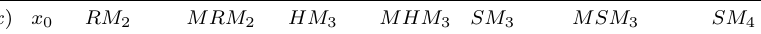
Table 4. Test Problem (6.2) f ( x ) x 0 RM 2 MRM 2 HM 3 MHM 3 SM 3 MSM 3 SM 4 Comparison of different iterative methods with the same TNFE=12 − 0 . 4 4.6( − 382) 4.6( − 466) 4.0( − 72) 3.7( − 75) 1.0( − 175) 1.6( − f 2 ( x )